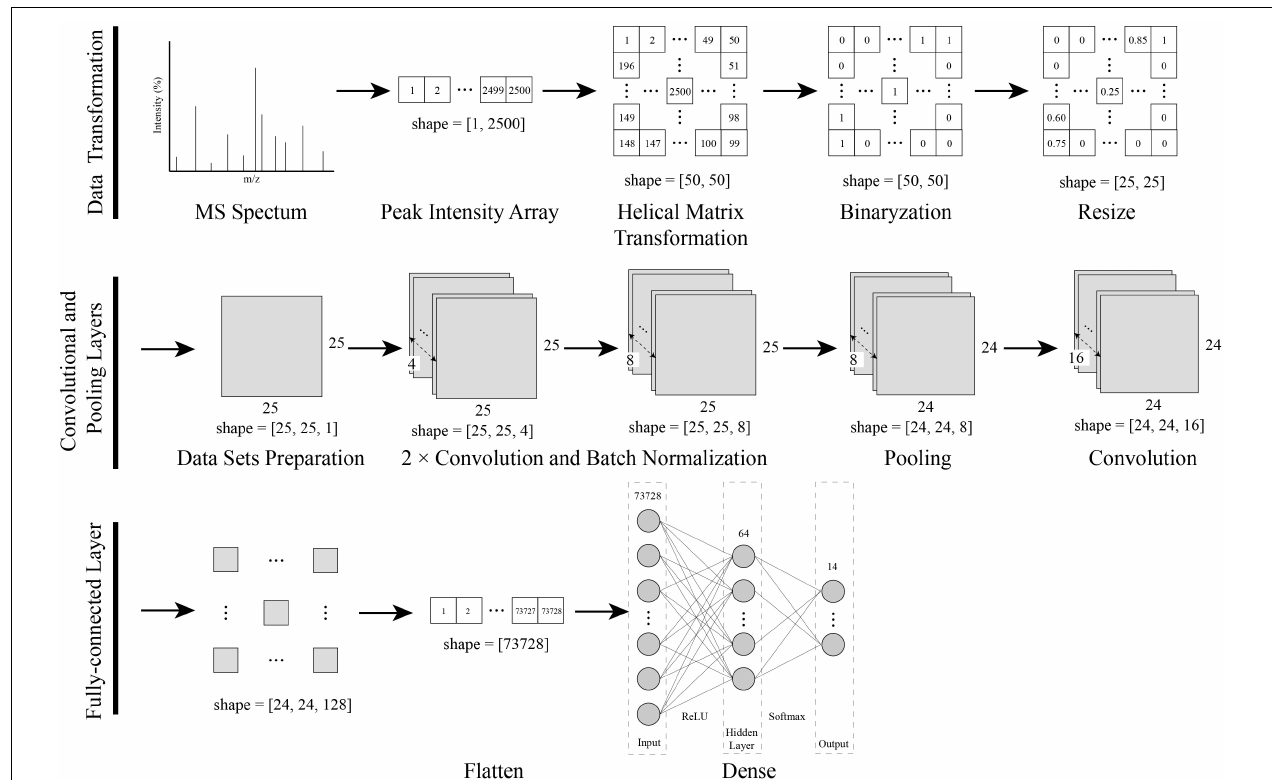
FIGURE 1 | Procedures of the data transformation combined with the CNN modeling. The one-dimensional MS spectra were converted into a two-dimensional matrix with a novel helix matrix transformation method. The two-dimensional matrix data were binarized and resized, and then compressed into a dataset for CNN training. Finally, a CNN model with convolutional, pooling and, dense layers was created and trained with a